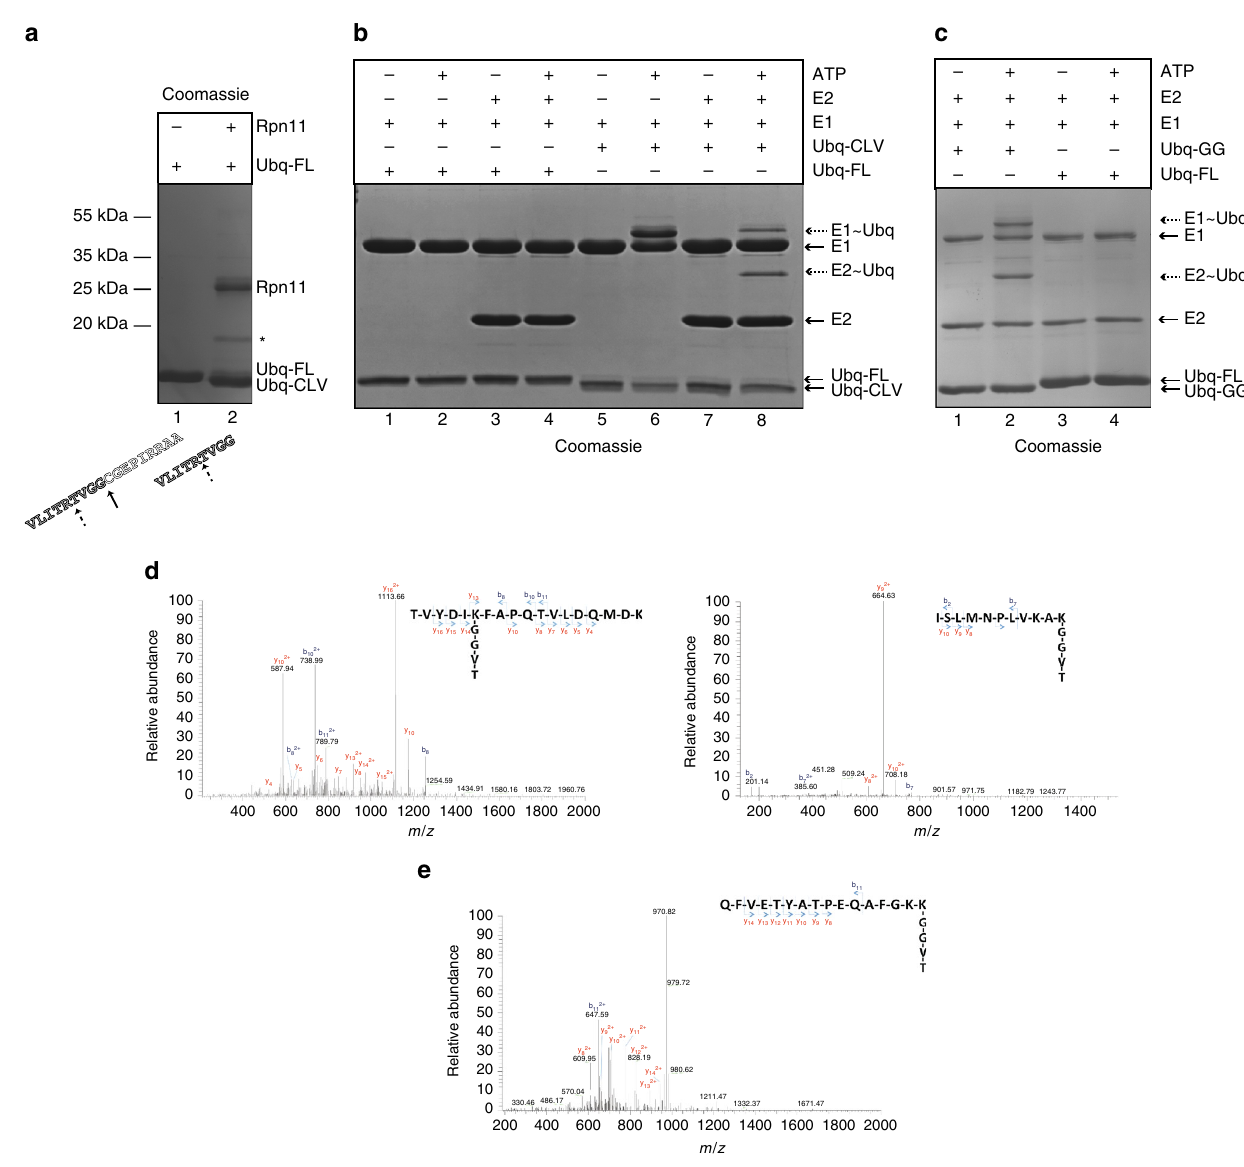
Fig. 2 Rpn11/JAMM metalloprotease cleavage of the C. subterraneum ubiquitin precursor to generate a canonical C-terminal di-glycine motif that is subsequently activated by the E1-like enzyme. a C. subterraneum Rpn11 speci fi c cleavage of the C-terminus of the pro-ubiquitin generates a mature ubiquitin species. Lane 1: pro-ubiquitin only; lane 2: pro-ubiquitin plus Rpn11. (Asterisk: C-terminal truncation of Rpn11). b Auto-ubiquitylation of the E1-like and E2-like components by ATP-dependent conjugation of the cleaved ubiquitin species via the exposed ubiquitin di-glycine motif. Lane 1 and 2: uncleaved, full-length, pro-ubiquitin (Ubq-FL) plus E1 in the presence and absence of ATP, respectively; lanes 3 and 4 as in lanes 1 and 2 but with the inclusion of the E2-enzyme; lanes 5 – 8 as in lanes 1 – 4 but using Rpn11-cleaved ubiquitin (Ubq-CLV) (assay at 60 °C for 15 min). c Ubiquitin truncated by a stop-codon after the di-glycine motif (Ubq-GG) also auto-ubiquitylates the E1-like and E2-like proteins. Reactions using Ubq-GG in the absence or presence of ATP are displayed in lanes 1 and 2, respectively ( cf Ubq-FL shown in lanes 3 and 4). Reactions were performed as described in b . Products in a , b and c separated by SDS-PAGE and visualised by Coomassie staining. The C-terminal Rpn11-speci fi c cleavage site in pro-ubiquitin is displayed below panel a (solid arrow). Trypsin digestion (dashed arrow) results in the generation of the ‘ TVGG ’ moiety detected as an isopeptide linkage in the tandem mass-spectrometry analyses. d MS/MS spectra of the auto-ubiquitylated E1 peptides following trypsin digestion to generate the ‘ TVGG ’ isopeptide linked moiety. m/z values of the precursor ions are shown in the top left of each panel. (2+) indicates doubly charged precursor ions. Spectra show the annotated peaks that are due to C-terminal y (coloured red) and N-terminal b (coloured blue) fragment ions. In each case, the m/z values of the precursor ions and the m/z values of the fragment ions are consistent with lysine residues modi fi ed with the ‘ TVGG ’ moiety. The amino-acid sequence of the trypsin-generated peptide, including the ‘ TVGG ’ modi fi ed lysine, is shown within in each example. e MS/MS spectra of the auto-ubiquitylated E2 peptide, as described in